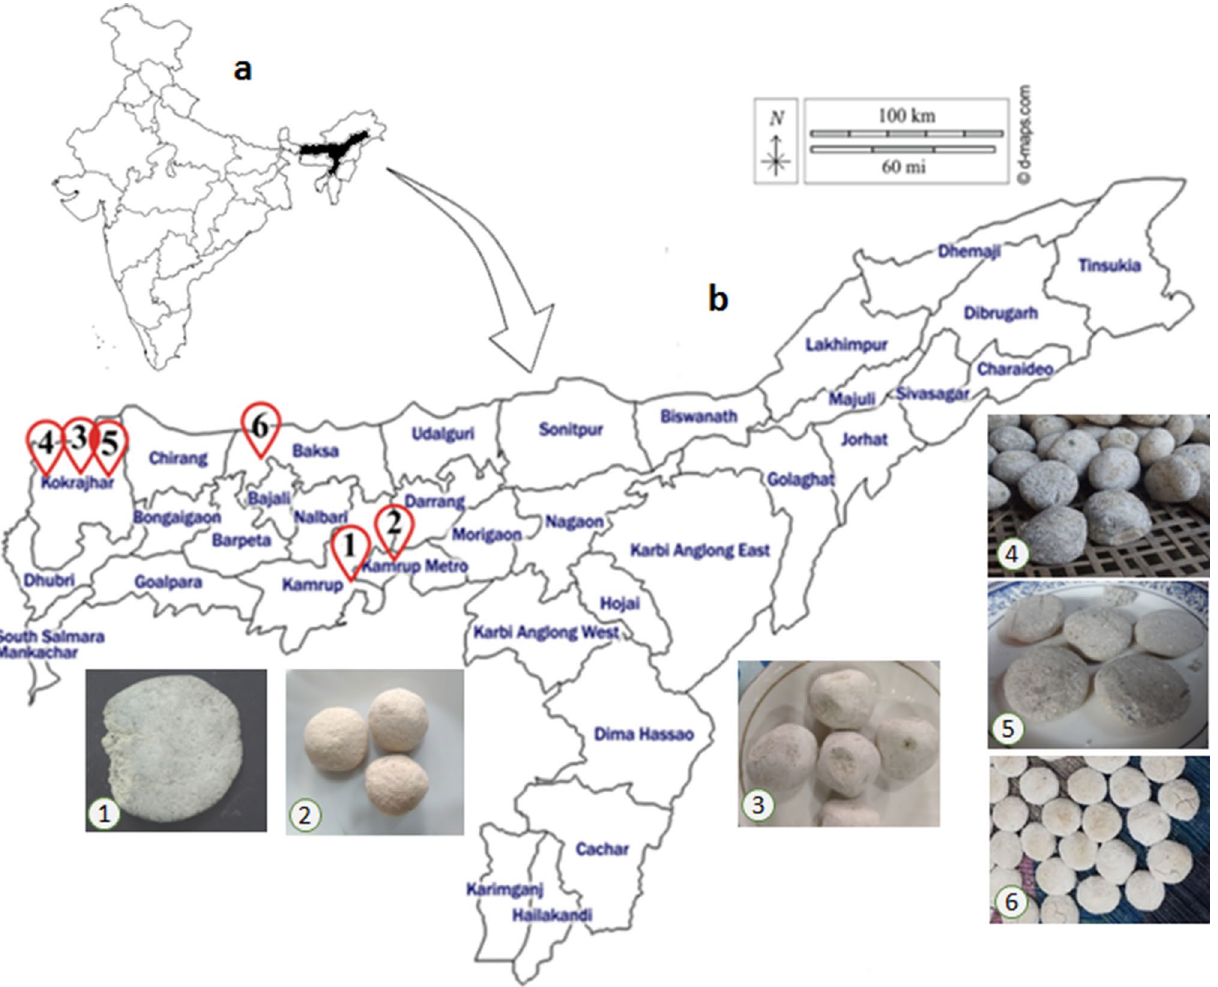
Figure 6. Map showing the emao sampling sites. (a) Map of India with Assam state highlighted in dark, (b) map of Assam marked with the emao sampling sites (red). Sample numbers (S. No.) are as given in Table 1. The map templates were taken from d-maps.com (https://d- maps. com/ pays. php? num_ pay= 84& lang= en & ) and the sampling sites were marked upon it using Adobe Photoshop CS (Version 8.0, 2003). The photographs of the emao samples were taken by D. Narzary and Nitesh